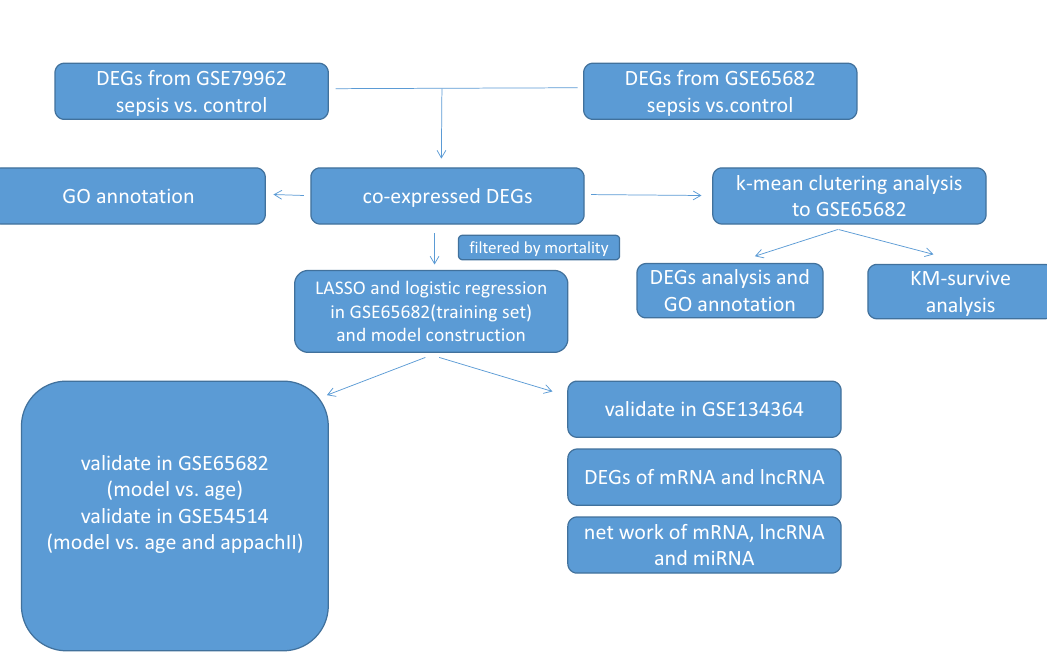
Figure 1. Flow diagram presenting the framework of our study, including the main statistical methods and procedures